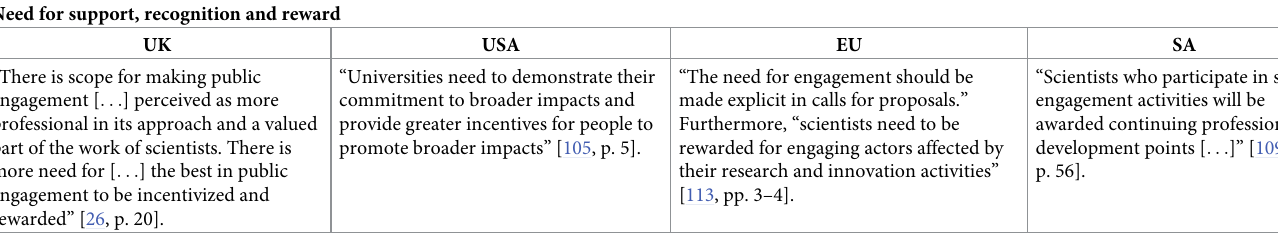
rewarded” [26, p. 20].